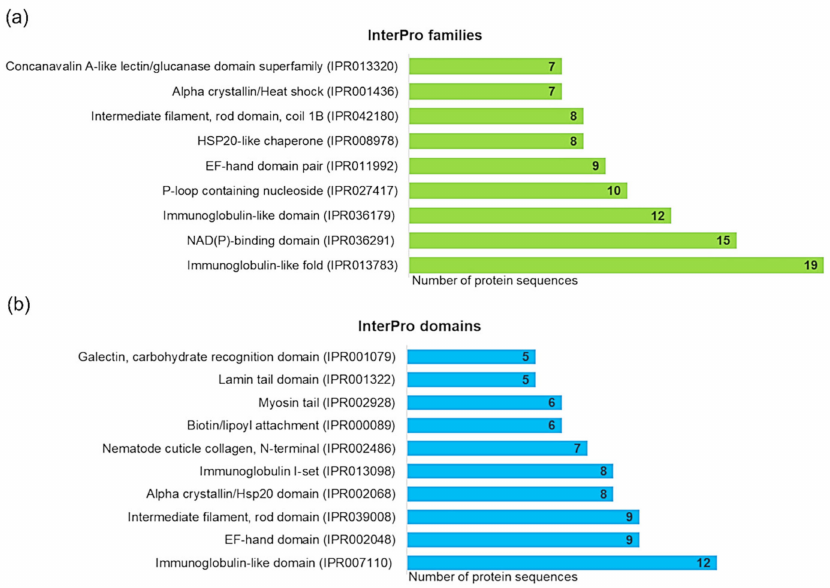
Figure 3. Results of the InterPro analysis of all detected proteins performed using OmicsBox software. Most abundant InterPro families ( a ); most abundant InterPro domains ( b